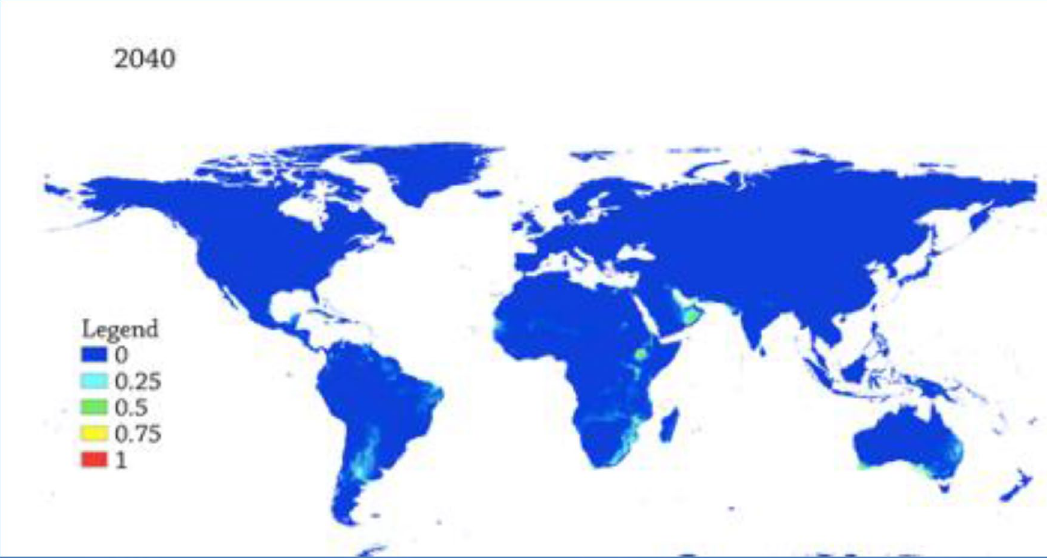
Figure 5. Predicted future global distribution gradient of AHS from 2020 to 2040. The warmer areas depict suitable areas while the cooler colors depict unsuitable localities.